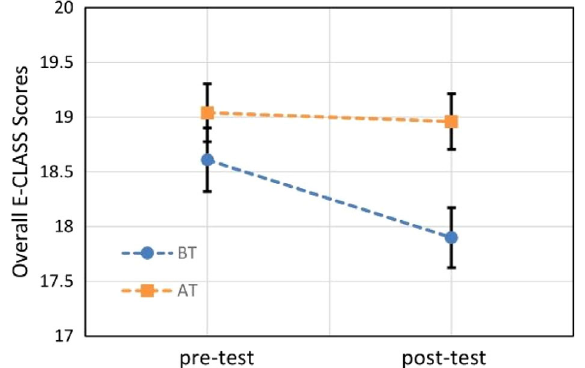
FIG. 2. Average overall pretest and post-test E-CLASS scores for women in the BT (blue, N ¼ 382 ) and AT (orange, N ¼ 522 ) offerings. Error bars are 95% confidence intervals.